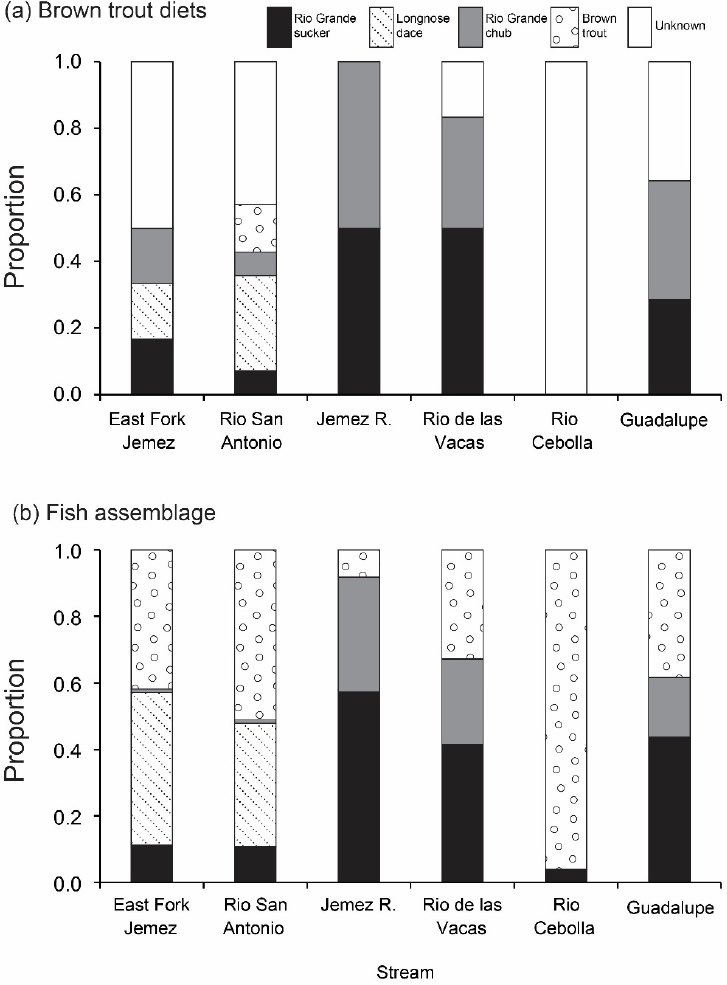
Figure 3. ( a ) Proportion of native fishes within Brown Trout ( Salmo trutta ) diets for all six sites from July to October. Unknown diet items were too digested to identify to species. ( b ) Proportional composition of native fishes sampled in each study stream.